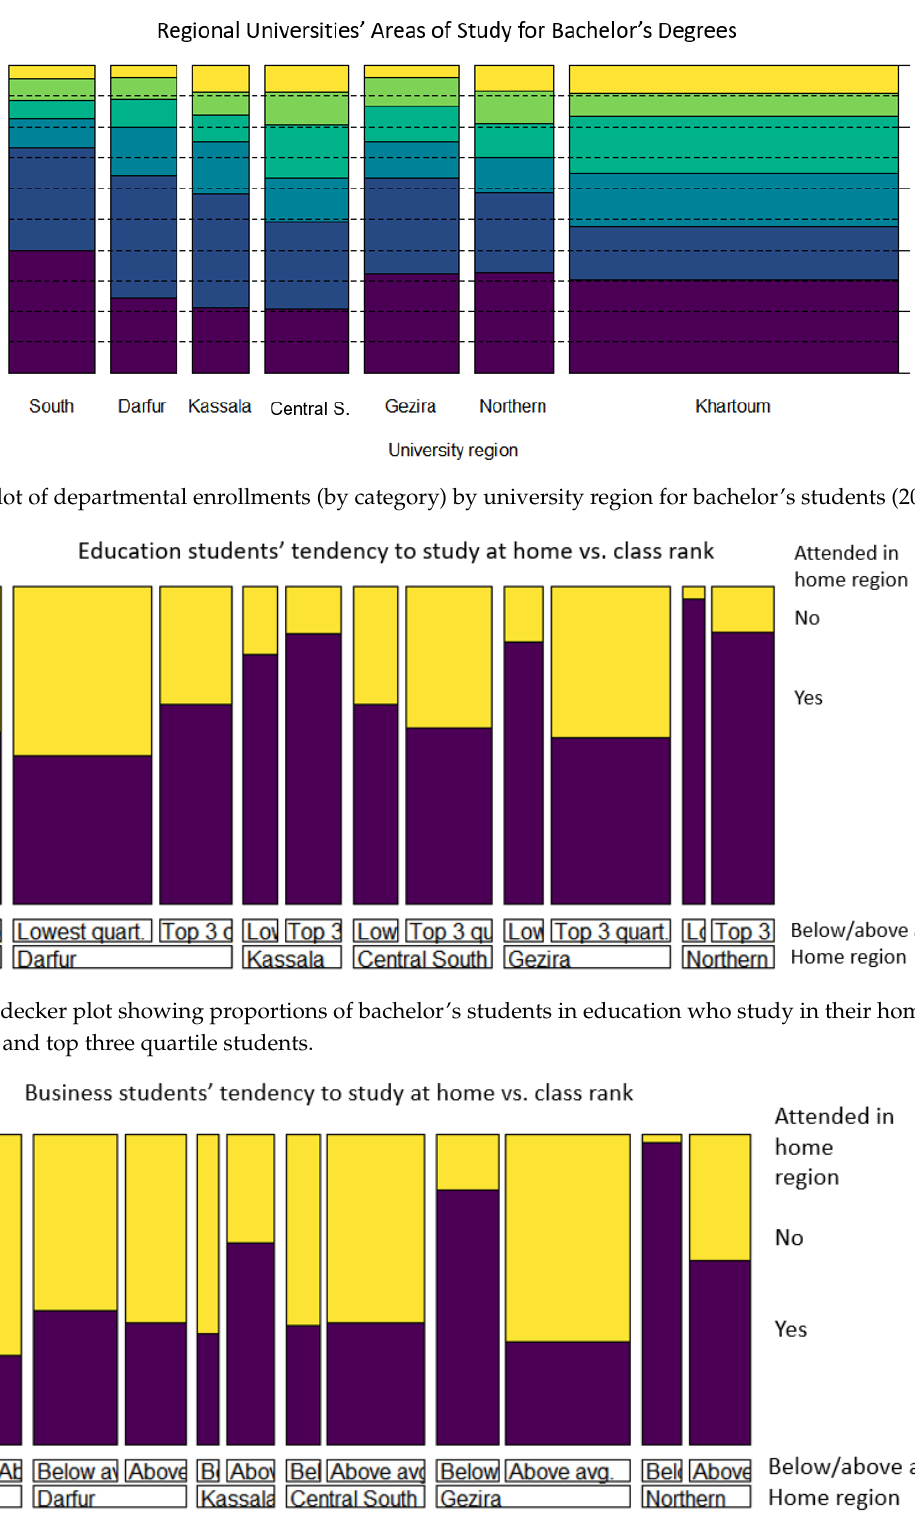
Figure 26. Double-decker plot showing proportions of bachelor’s students in business who study in their home regions, for lowest-quartile and top three quartile